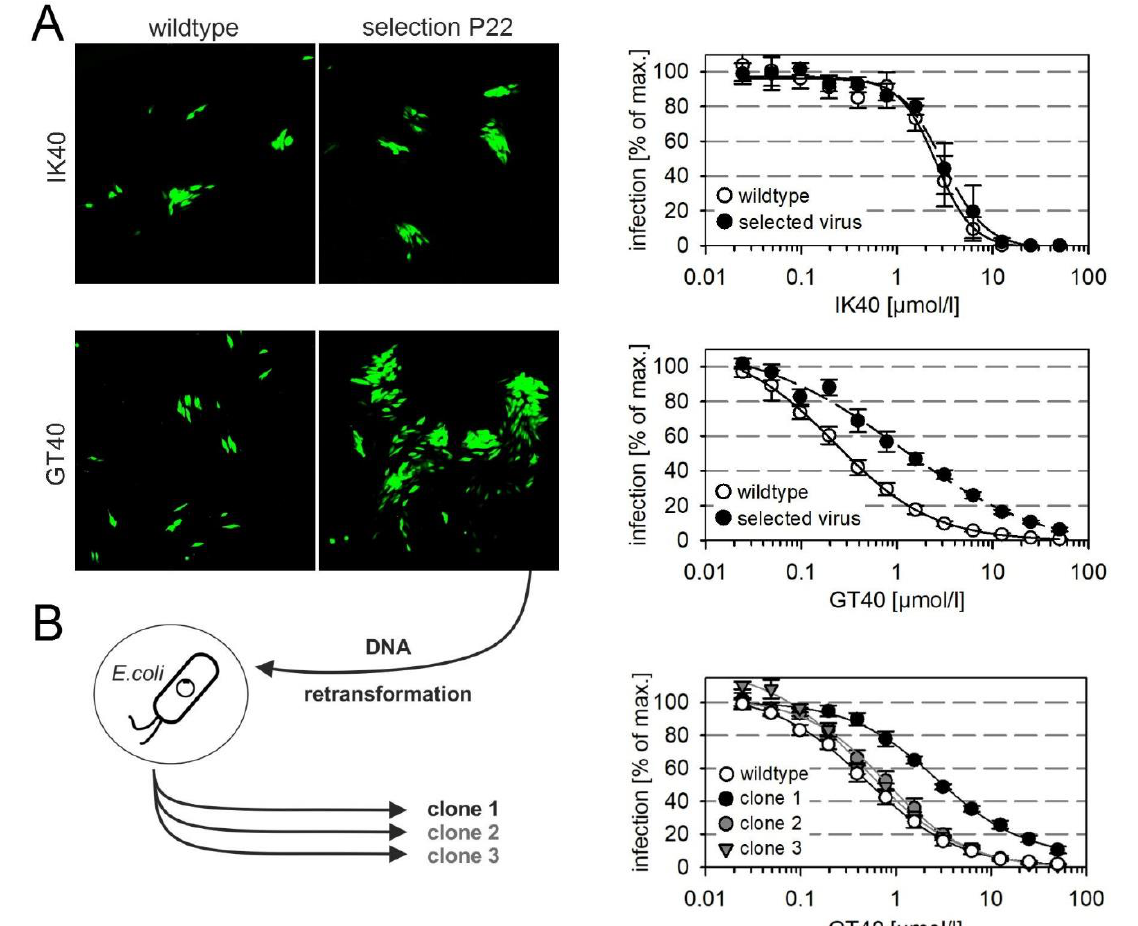
Figure 3. Selection of viruses with resistance against PDGFR α -derived inhibitory peptides. The proofreading-deficient virus RV-HGUL54dD413 (AD169), which expresses the green fluorescent protein under the HCMV-IE promoter, was cultured on HFFs with peptides IK40 and GT40 at submaximal inhibitory dose (25 µ mol/L) for a period of 22 passages. Upon selection under GT40, enlarged foci were observed from passage 18. ( A ) Microscopic fluorescence images show the focal growth of wildtype and selected virus as reflected by EGFP expression, and the corresponding dose–response curves show the inhibitory effect of the respective peptide on wildtype and selected virus on cell-free infection of HFFs (n = 6; error bars = standard error of the mean). ( B ) To isolate genetically homogenous clones from the GT40-selectant, viral DNA was prepared from infected cell cultures and introduced into E. coli by electroporation. From bacteria with bacterial artificial chromosomes (BACs) containing intact viral genomes, DNA was prepared and transfected into fibroblasts to reconstitute virus. Viruses were then analyzed for sensitivity to the inhibitory peptide GT40 by dose–response experiments (n = 4; error bars = standard error of the mean). One of three clones showed reduced susceptibility to GT40, while the other two clones were almost indistinguishable from wildtype